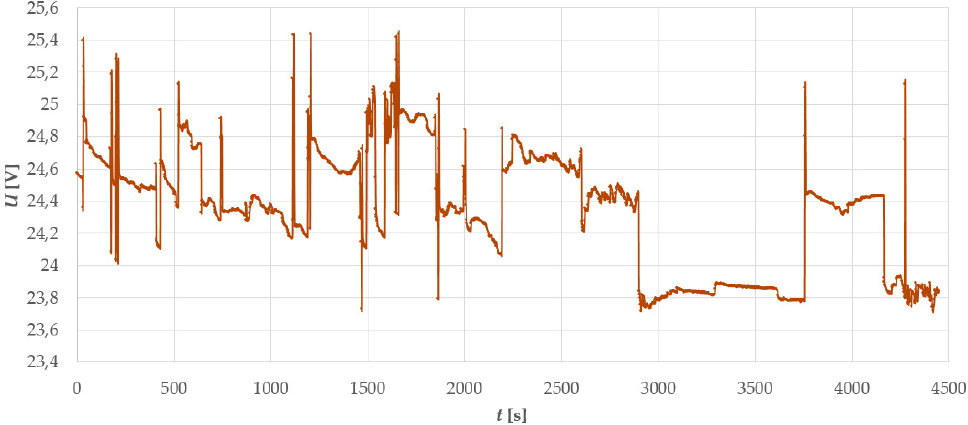
Figure 12. The grid voltage pattern related to time.